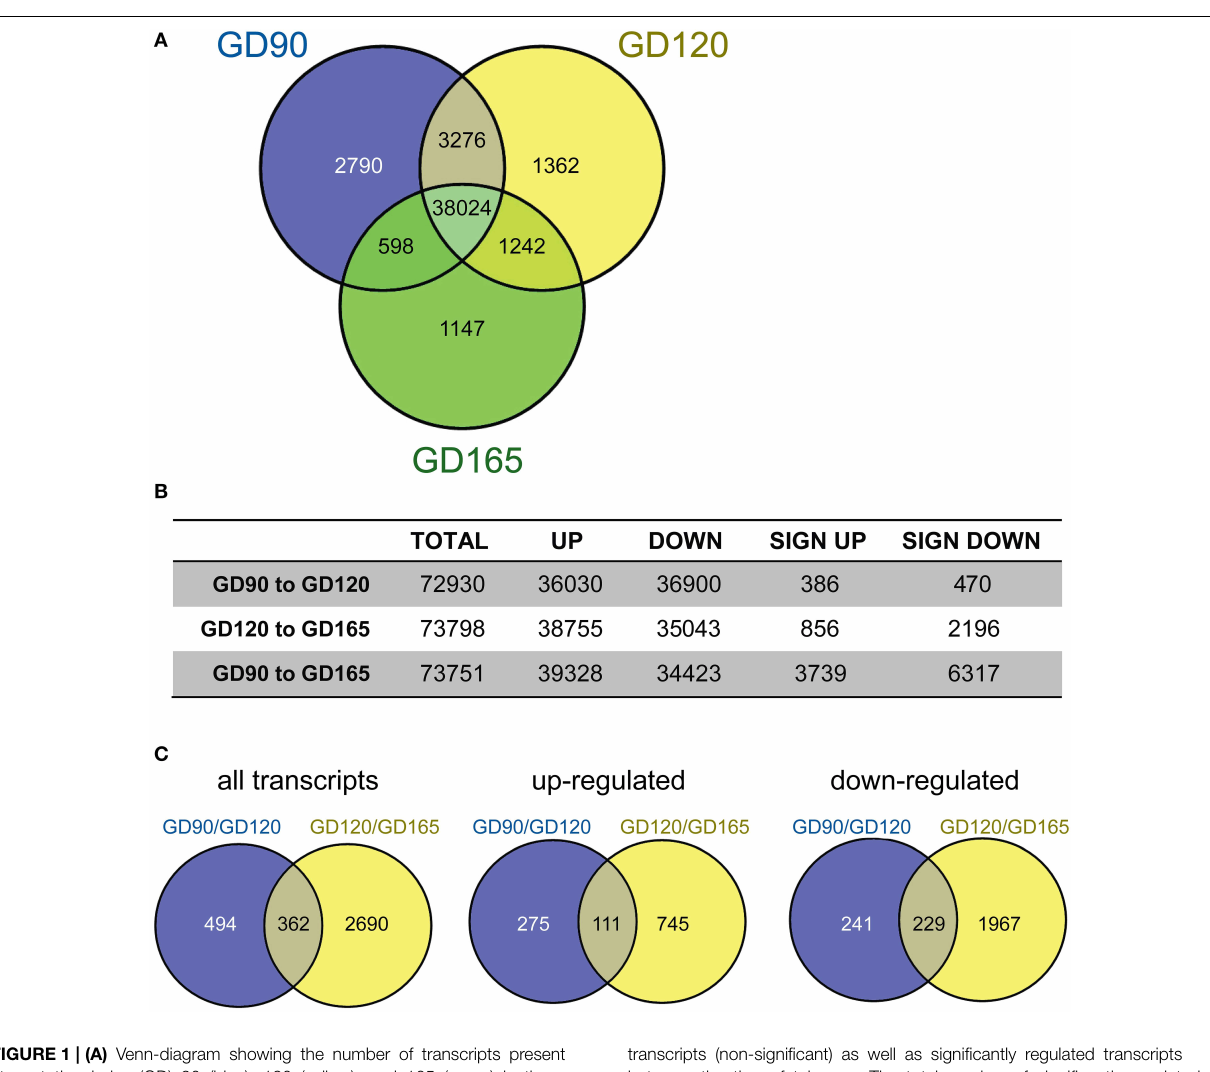
transcripts (non-significant) as well as significantly regulated transcripts between the three fetal ages. The total number of significantly regulated transcripts was less between GD90 and GD120 (856) than between GD120 and GD165 (3052) and greatest between GD90 and GD165 (10056). (C) Number of significantly regulated transcripts that were in common between the two pairwise comparisons GD90/GD120 and GD120/GD165 (left) as well as up-(middle) and down-regulated (right)